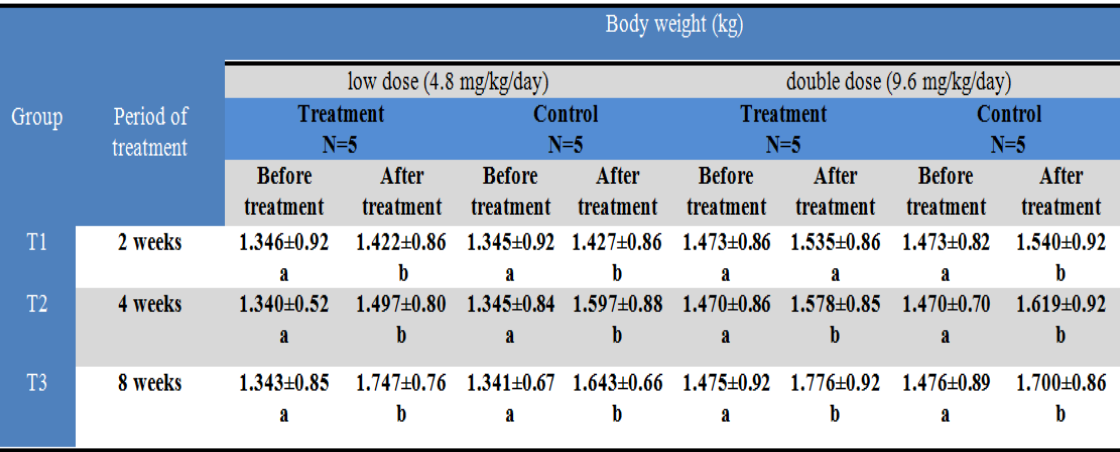
Table 1: Effect of orally administering a low dose (4.8 mg/kg/day) and double dose (9.6 mg/kg/day) of Citrullus colocynthis on the body weight of rabbits in different periods.